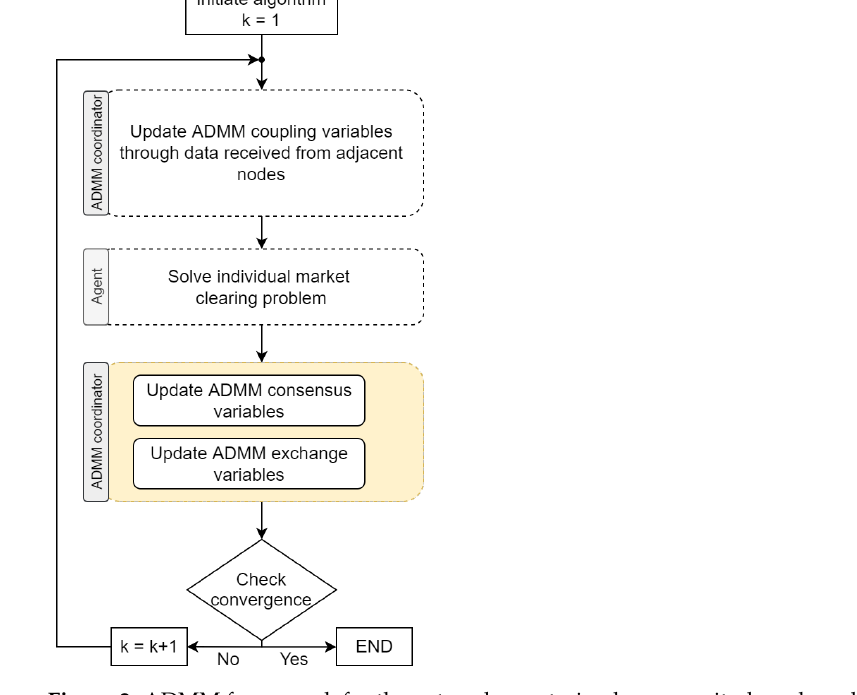
Figure 2. ADMM framework for the network-constrained community-based